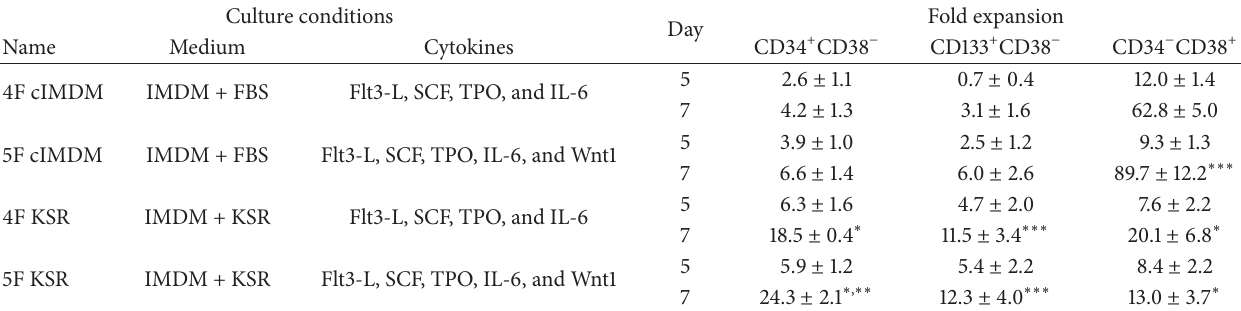
Table 2: Folds expansion of CD34 + CD38 − , CD133 + CD38 − , and CD34 − CD38 + cells under various cytokine culture conditions. Culture conditions